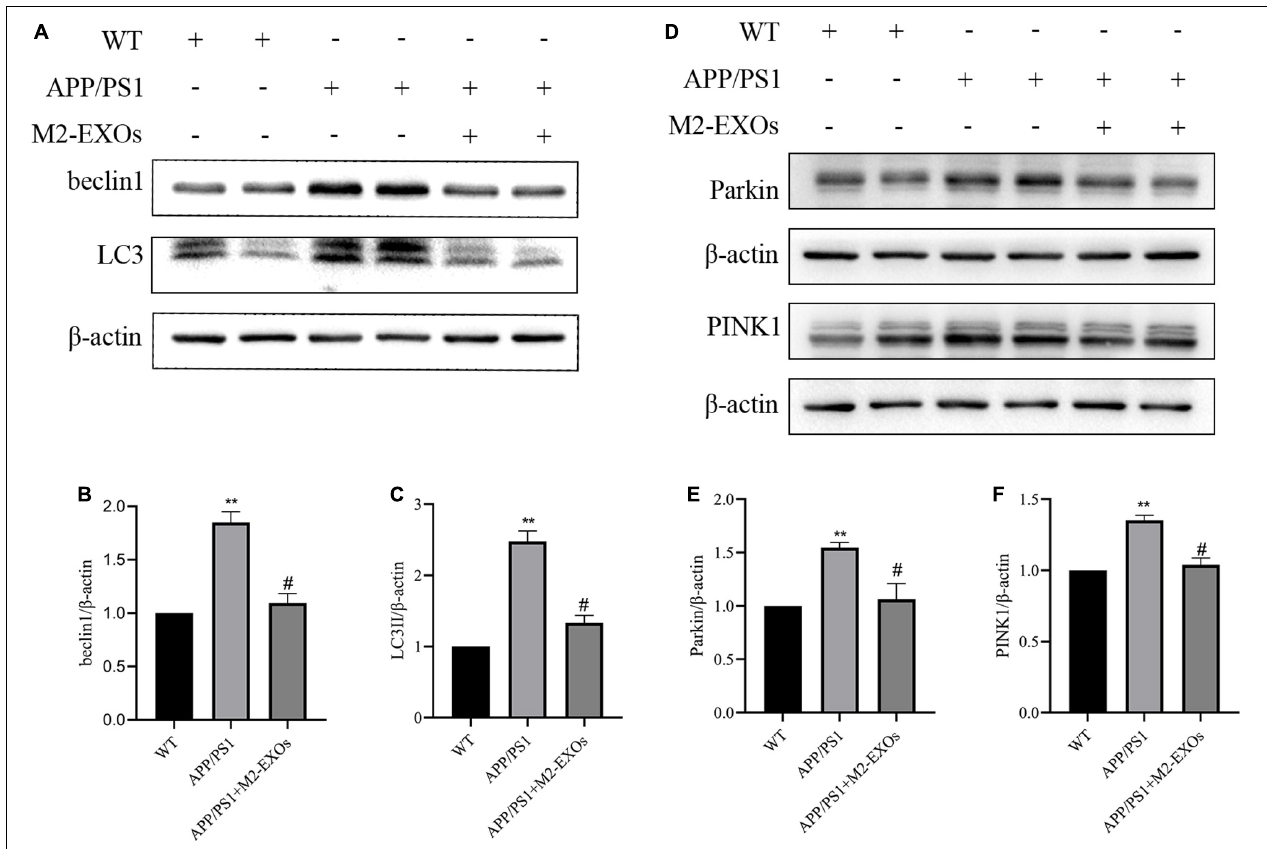
FIGURE 8 | M2-EXOs inhibit autophagy by inactivating PINK1/Parkin signaling in APP/PS1 mice. (A) Brain expression of LC3II and beclin1 assessed by western blot analysis. (B,C) Quantification of LC3II and beclin1 expression. (D) Brain expression of PINK1 and Parkin assessed by western blot analysis. (E,F) Quantification of PINK1 and Parkin expression. ** P < 0.01 vs. WT, # P < 0.05 vs.